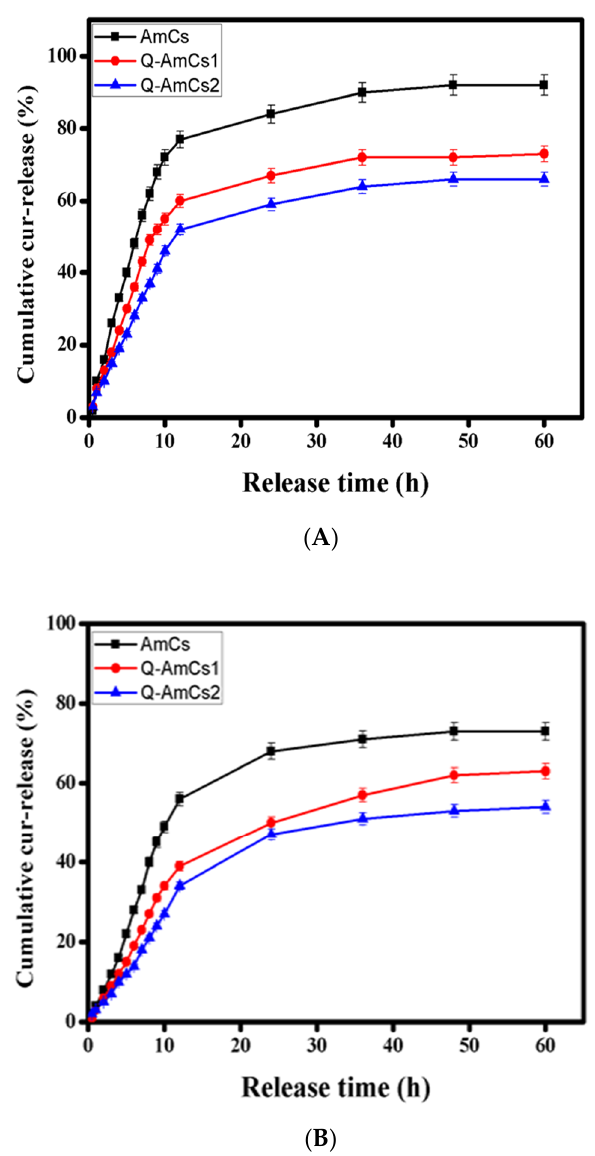
Figure 5. Cumulative Cur-release profiles of the formulated Cur-loaded NPs at ( A ) SGF (pH 1.2) and ( B ) SCF (pH 7.4). All measurements were performed in triplicates ( n = 3), and the values were expressed as mean + standard deviation (±SD).